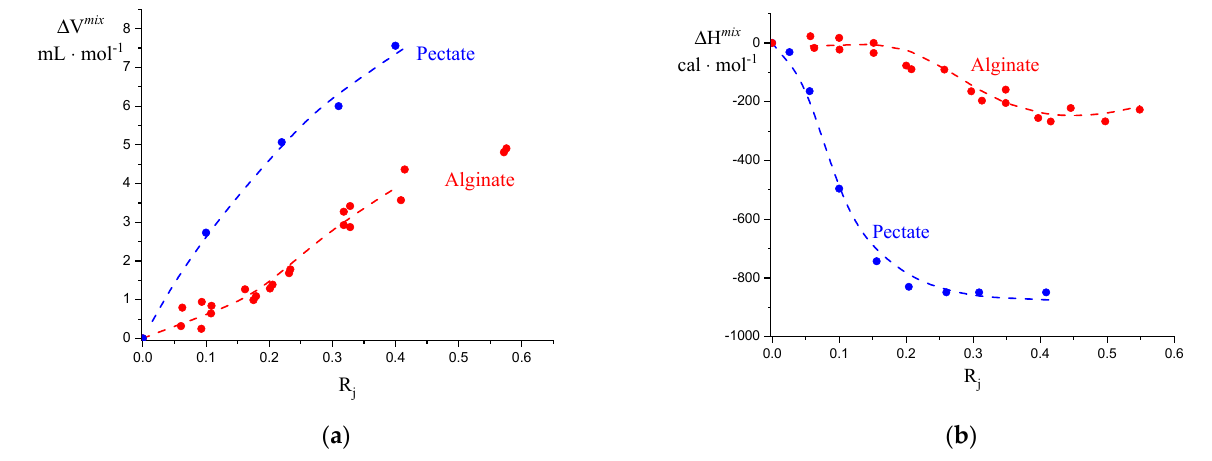
Figure 10. Volume ( a ) dilatometry and enthalpy ( b ) microcalorimetry change of mixing calcium ions with pectate (blue full circles) and L.hyp . alginate (red full circles) in aqueous 0.05 M NaClO 4 at 25.0 °C, as a function of R j (full black squares). Data taken from ref. [24]. af f Using the above determined value of ∆ H and following the formalism described